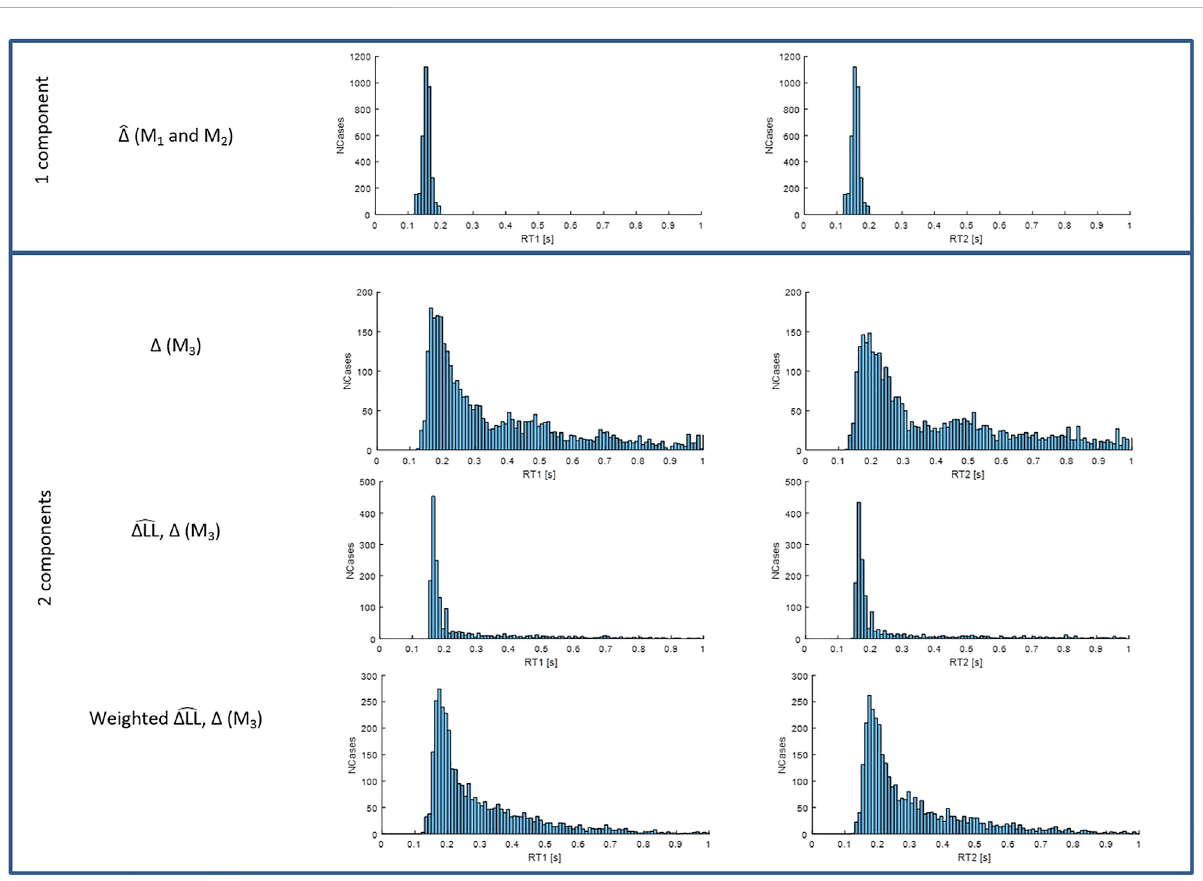
FIGURE 7 Distributions of RT1 ( fi rst column) and RT2 (second column) for models M1-3. Each subplot shows the number of cases ( y -axis) for each RT value within the physiological range ( x -axis). Row 1: fi xeddelay ^ Δ for models M1 ( ^ Δ ) and M2 ( ^ Δ ) . Row 2: variable delay Δ from two process model M3 ( (cid:3) Δ LL , Δ ).Row3: fi xeddelay ^ Δ andvariabledelays Δ frommodelM3( (cid:3) Δ LL , Δ